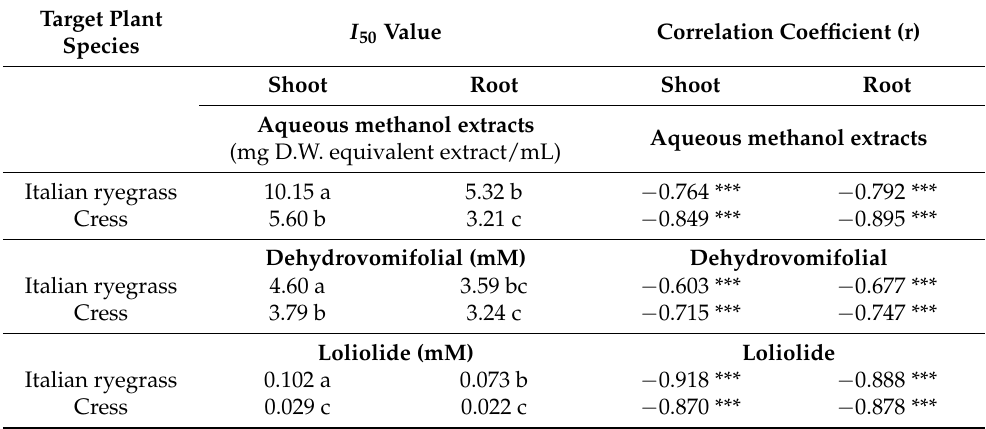
Table 1. The concentration required for 50% inhibition ( I 50 ) of the shoots and roots of Italian ryegrass and cress by the Dregea volubilis leaf extracts and its related compounds (dehydrovomifoliol and loliolide), and their respective correlation coefficient